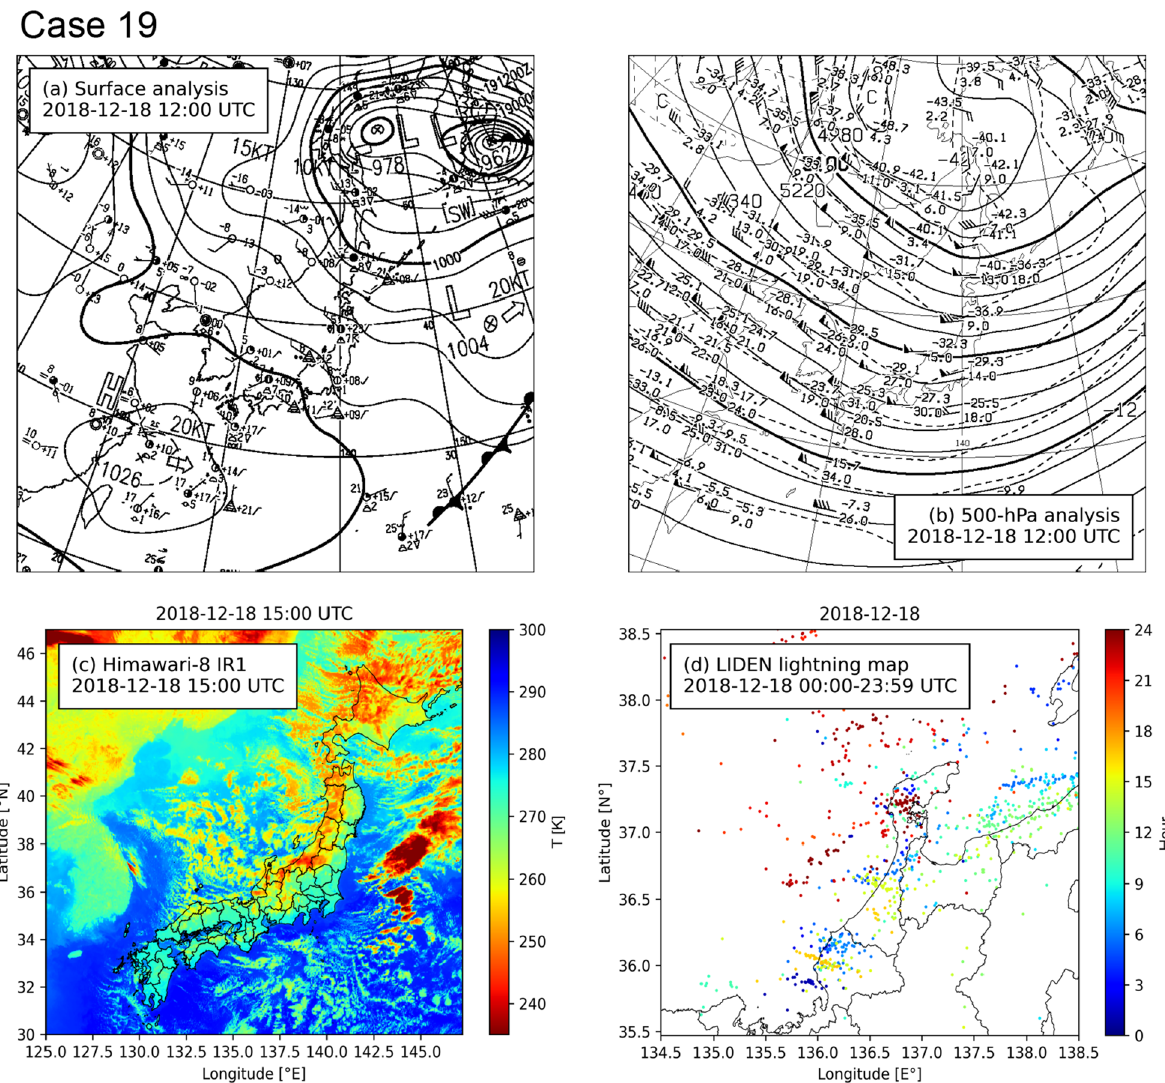
Fig. 4 Meteorological charts of the glow-detection Case 19 in the same format as Fig.